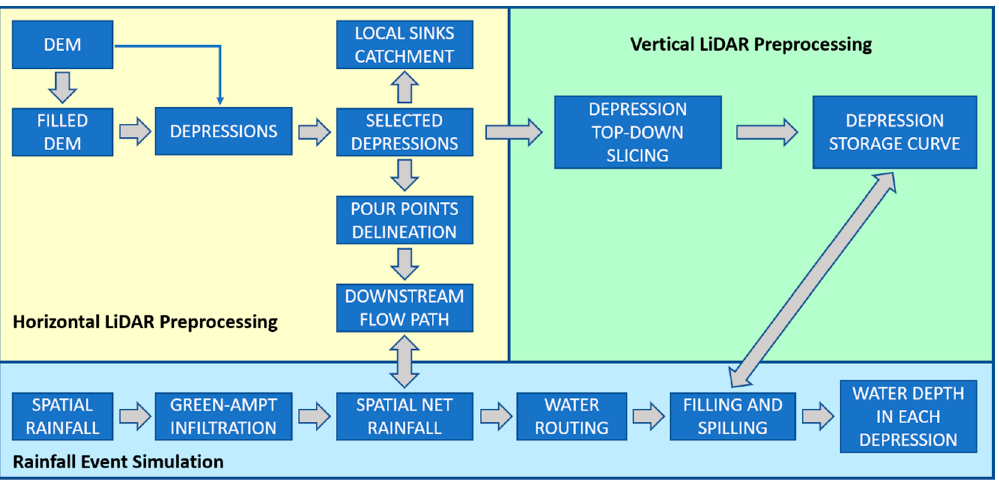
Figure 1. Safer_RAIN work-flow, distinguishing between DEM preprocessing (horizontal and vertical) and pluvial flooding simulation.